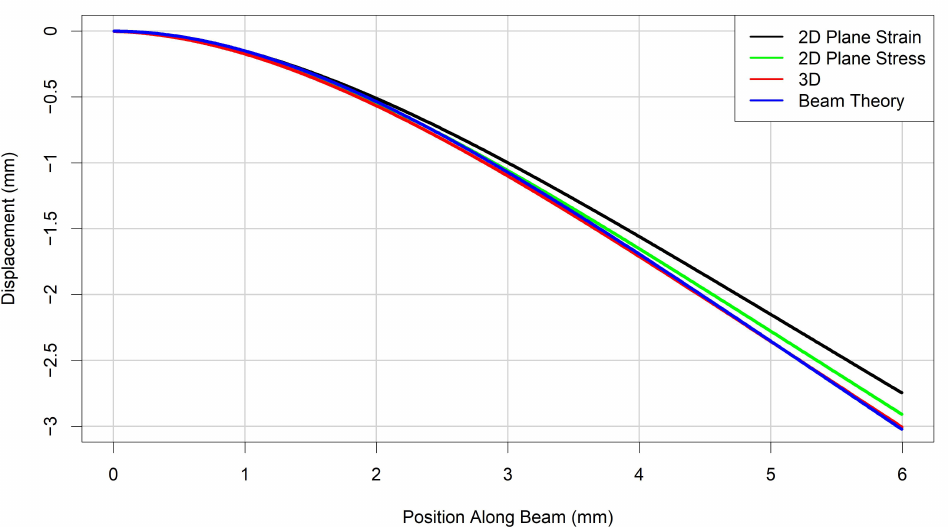
Figure 2. Comparison of displacements calculated along the length of a beam calculated using different modelling